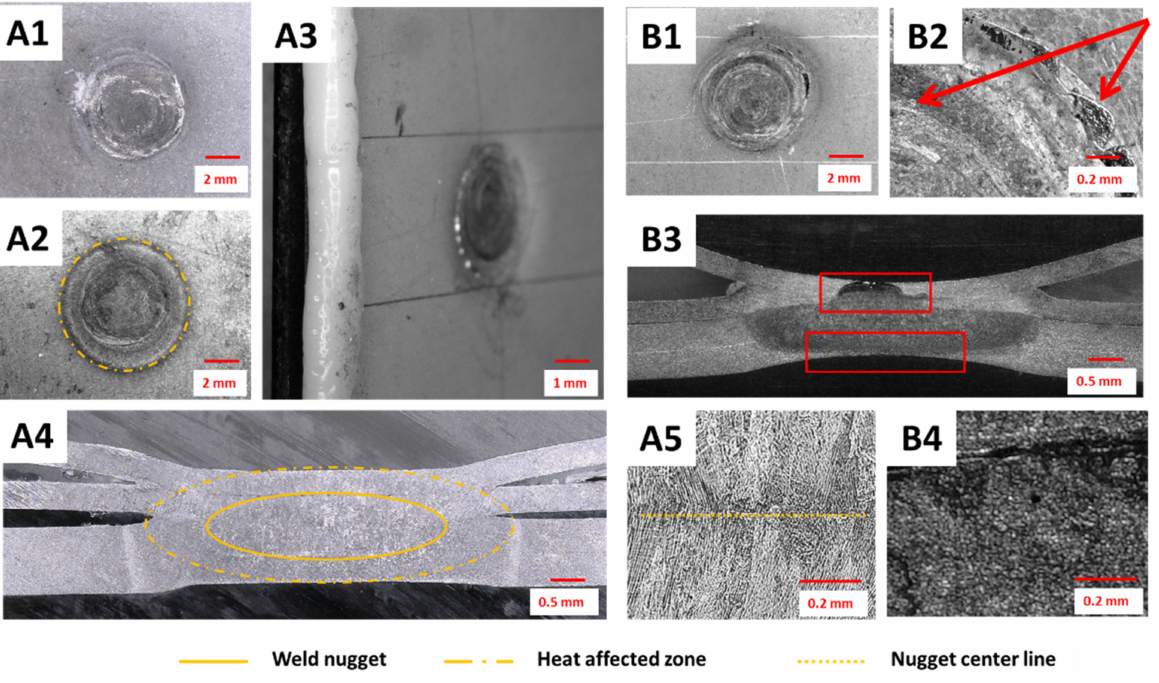
Figure 11. Examples of spot welds manufactured by induction heating-assisted RSW: properly ( A1 ) top view, ( A2 ) bottom view, ( A3 ) side view, ( A4 ) cross-section at low magnification, and ( A5 ) weld nugget at high magnification and non-properly formulated: ( B1 ) top view, ( B2 ) top view magnified, ( B3 ) cross-section at low magnification, and ( B4 ) weld nugget at high